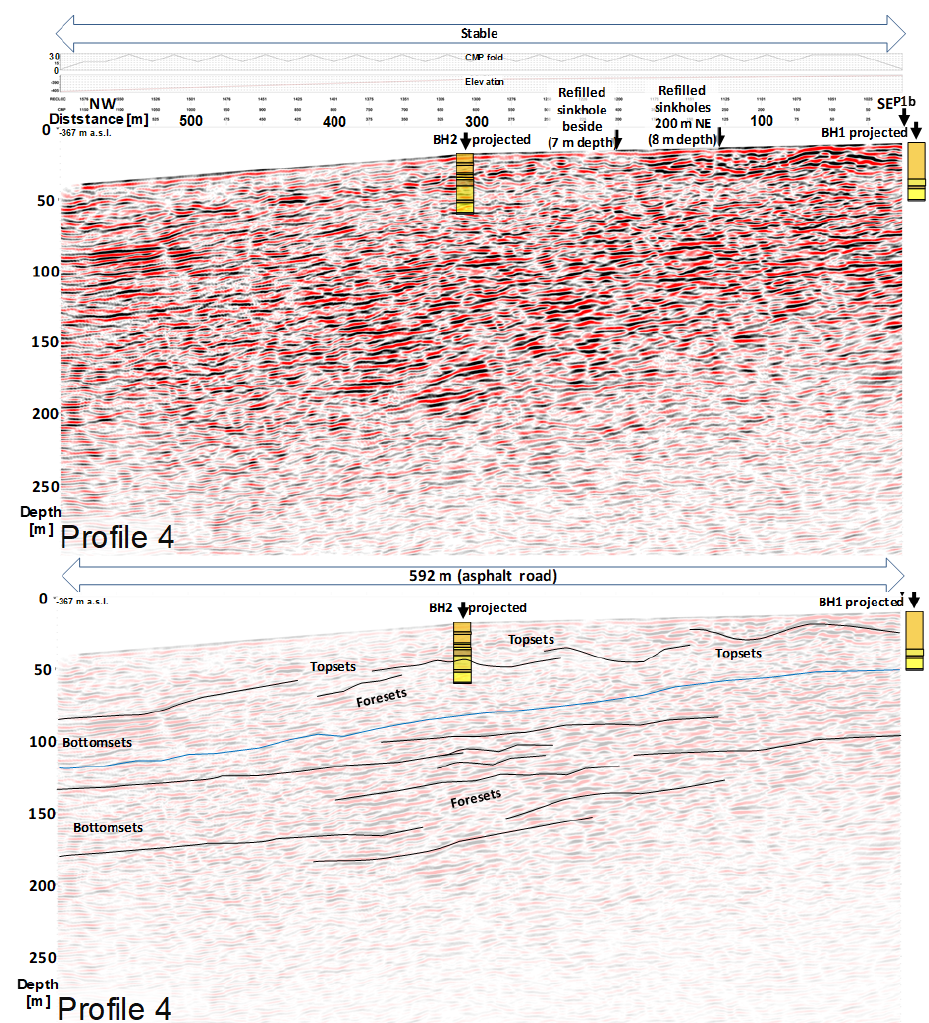
Figure 11. Depth section of profile 4 after post stack FD time migration (a) and interpretation of the main structure elements (b) . For annotations, see Fig. 8. Lithology of boreholes BH1 and BH2 is projected from 200m distance perpendicularly into the profile. In contrast to profile 2, more gently northwest-dipping events are present to 150m depth, indicating less transportation energy of the alluvial material or an apparent structure dip. The top of the silt and clay layer in BH1 and BH2 is indicated by the blue line. Bowl-shaped signatures close to the surface in the southeast indicate sinkhole-caused subsidence and/or refilled channel side cuts. Significant reflection amplitudes of a stronger reflector pattern close to the northwest end at nearly 90m depth may indicate an evaporite-rich lens included in the alluvium–lacustrine